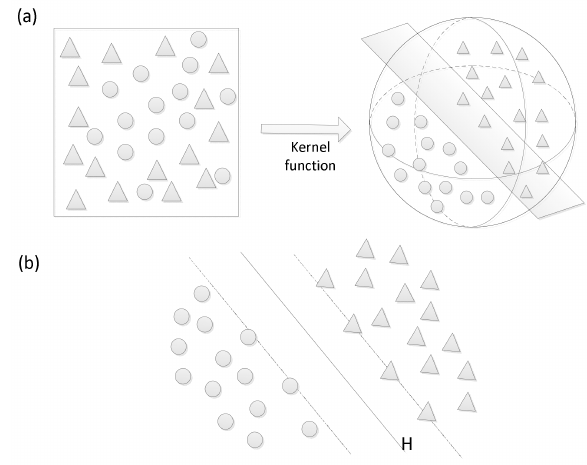
Figure 6. Explanation of the support vector machine (SVM principles): ( a ) the kernel function and ( b ) the optimal